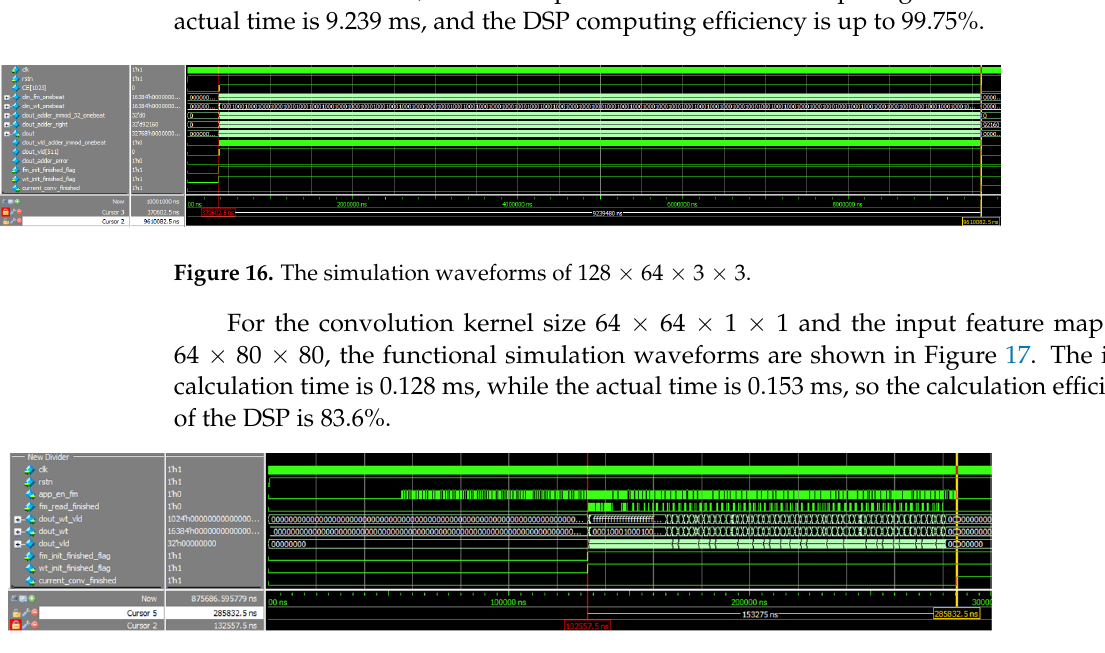
Figure 17. Simulation waveforms of 64 × 64 × 1 × 1.